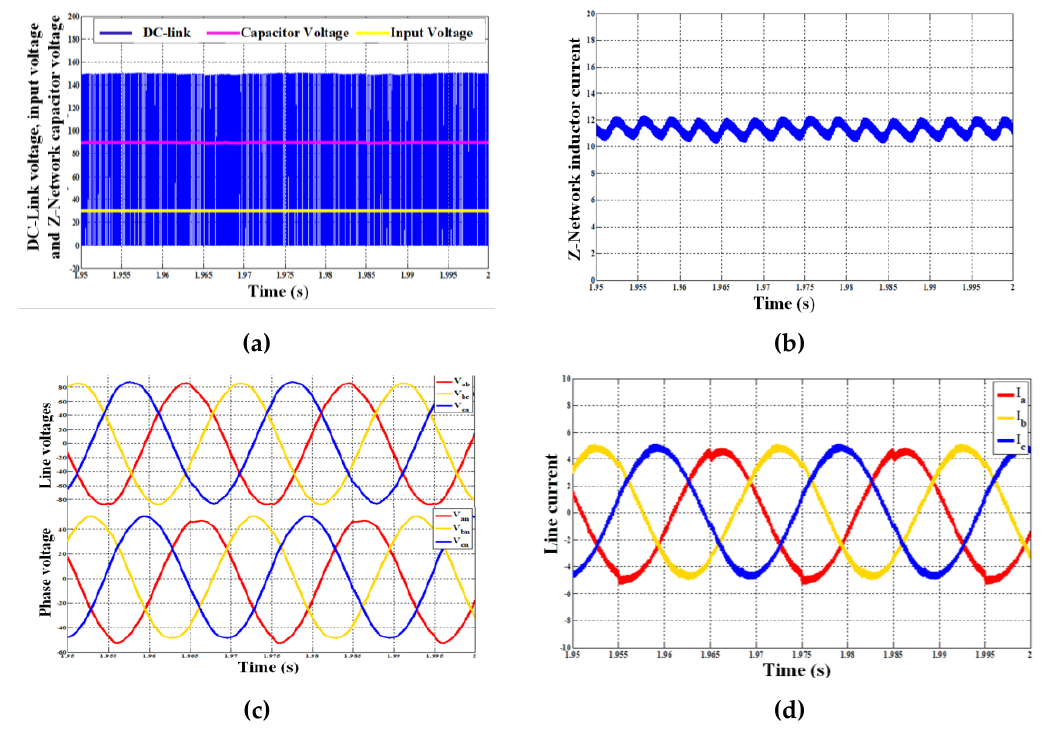
Figure 8. Simulation results of the proposed modified ZSI-DCPWM: ( a ) DC side voltages, ( b ) Z-network inductor current, ( c ) Output line and phase voltages, ( d ) Output line currents.